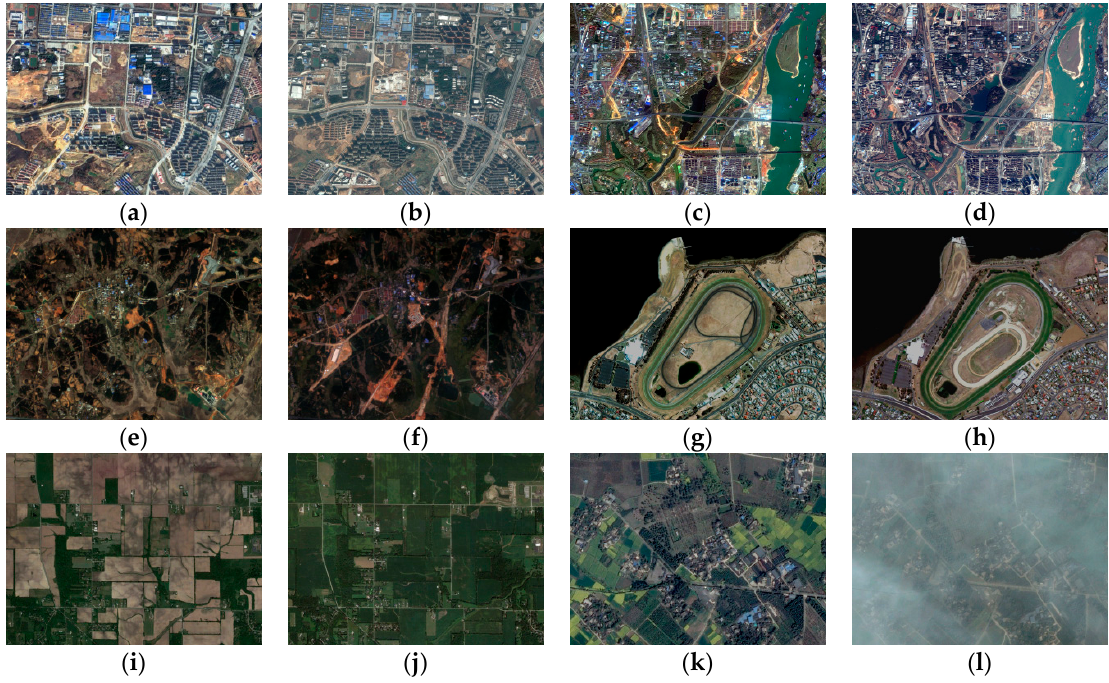
Figure 7. Experimental image pairs. ( a , b ) is a pair of ZY3 (fusion image obtained from multispectral and panchromatic images) and Google Earth images in an urban area in China. ( c , d ) is a pair of GF1 (fusion image obtained from multispectral and panchromatic images) and Google Earth images in China. ( e , f ) is a pair of ZY3 and GF1 images with large background variations in a mountain area in China. ( g , h ) is a pair of IKONOS and Google Earth images with coastline in Australia. The images in ( i , j ) are a pair of Google Earth images with farmlands in different seasons in the United States. ( k , l ) is a pair of Google Earth images in China, in which ( l ) is contaminated by cloud and haze. Table 1. Description for each pair of images in the experiments.